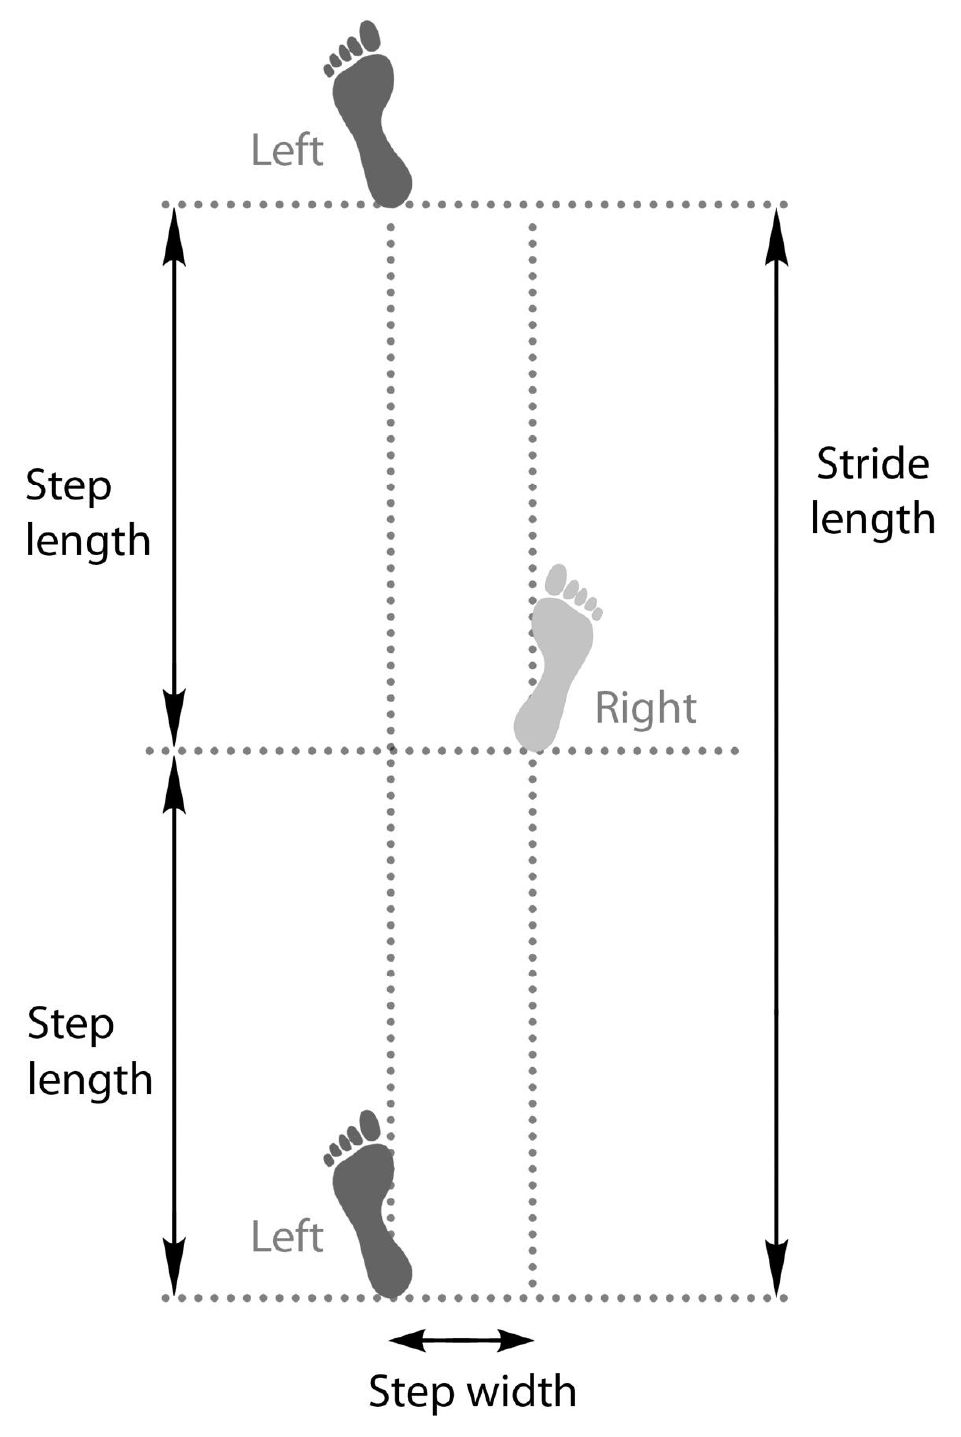
Figure 2. Diagram to illustrate the gait cycle parameters of stride length, step length and step width.